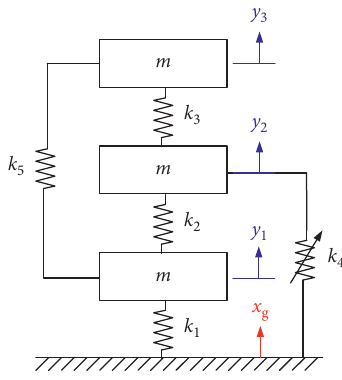
Figure 4: A 3-DOF oscillating system with linear and nonlinear springs.